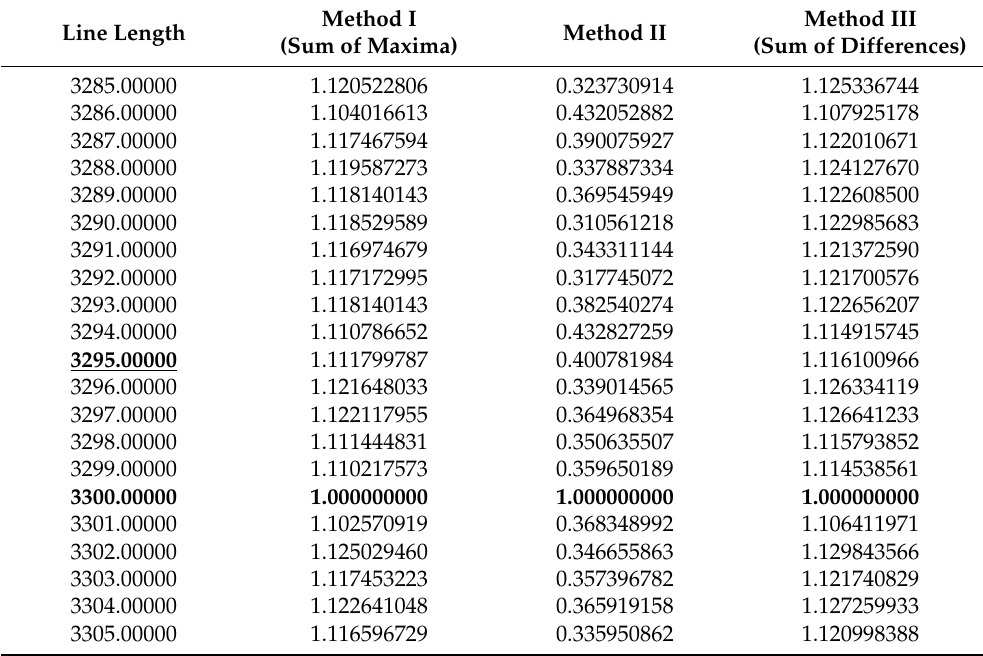
Table 12. Image line length estimation results for the accuracy ∆ =